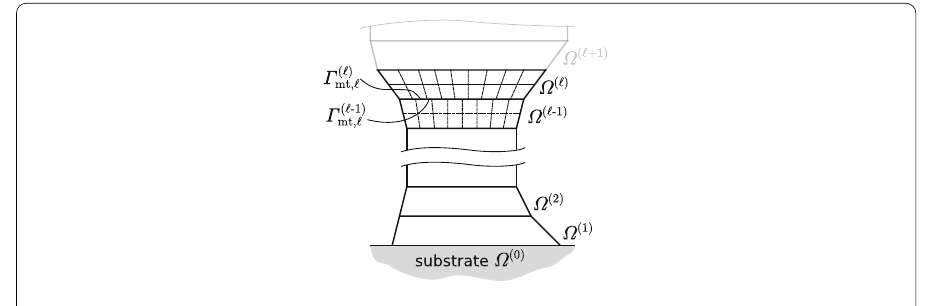
Fig. 13 Mesh tying concept for multilayer PBFAM